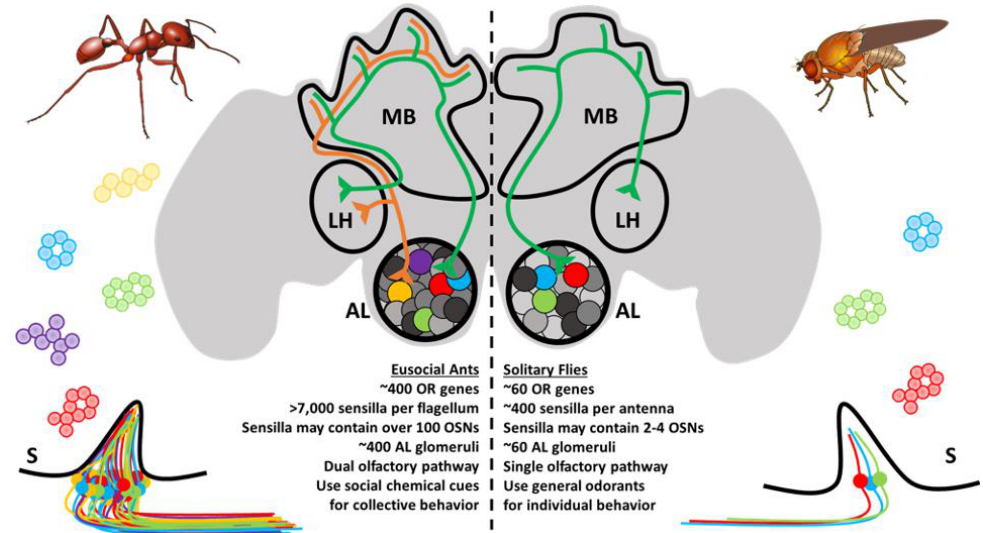
Figure 2. Ants and other eusocial Hymenopteran have a remarkably complex olfactory system relative to fruit flies and other solitary insects. Ant sensilla (S) may contain OSNs that are up to two orders of magnitude more numerous than those of the fruit fly. The antennal lobe (AL) glomeruli are also more numerous and follow a different developmental trajectory. Odor processing in higher-order brain structures, including the mushroom bodies (MB) and lateral horn (LH), occurs through a novel dual-olfactory processing